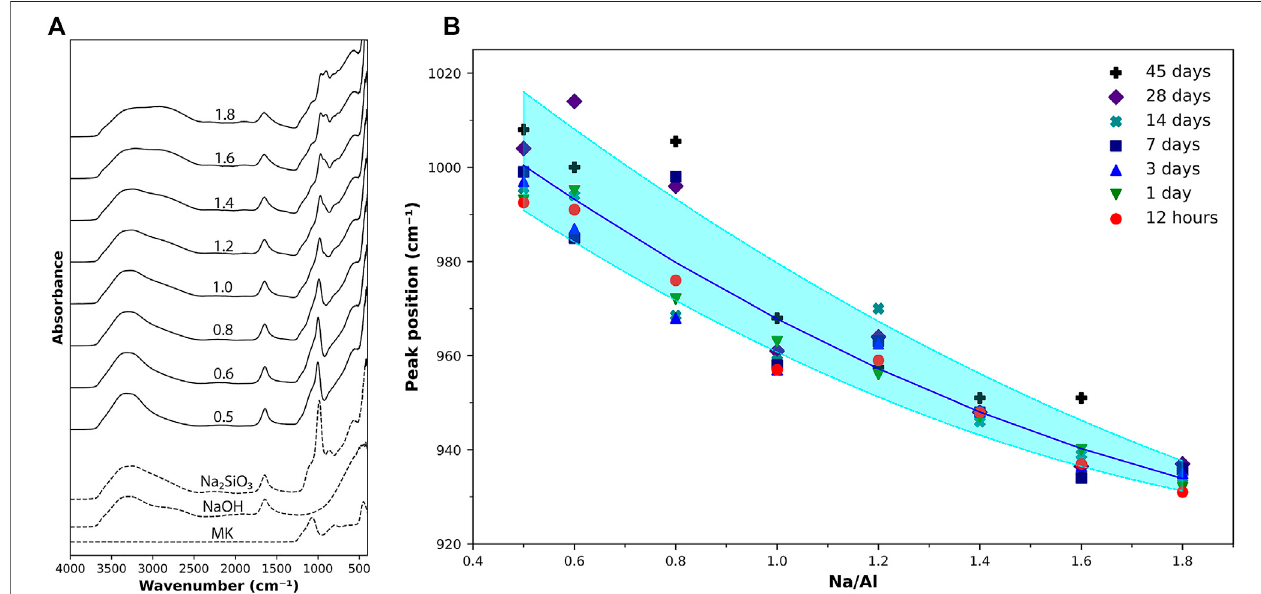
FIGURE2 |(A) FTIR scanresults on metakaolin, activating solutions,and AAMsampleswithvarious Na/Al ratios (as listed) scanned 15 min after activation. (B) Si- O-T peak position for various Na/Al ratios at different ages. The shaded region provides a guide to the eye of how the Na/Al ratio affects the peak position.